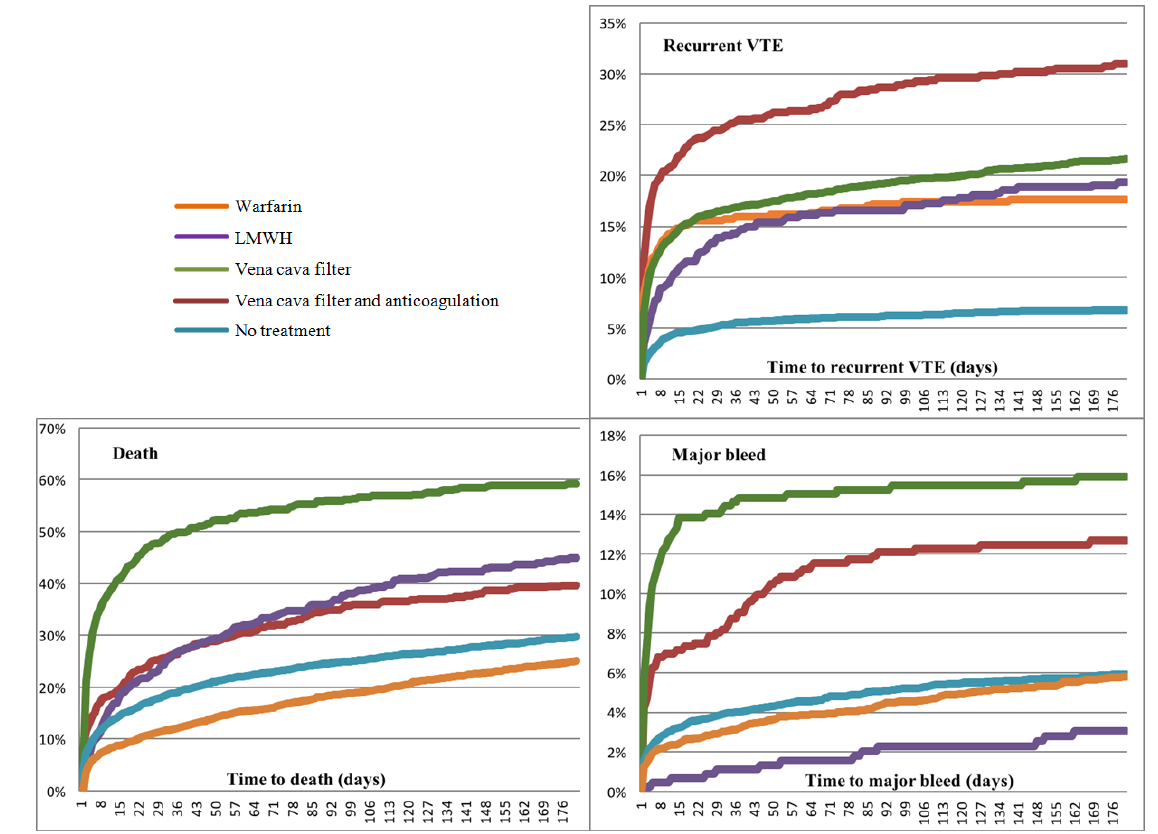
LMWH: low-molecular weight heparin; VTE: venous